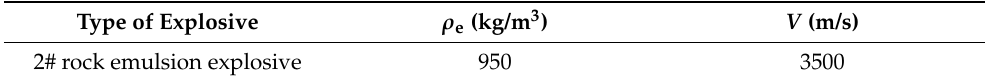
Table 3. Explosive parameters.